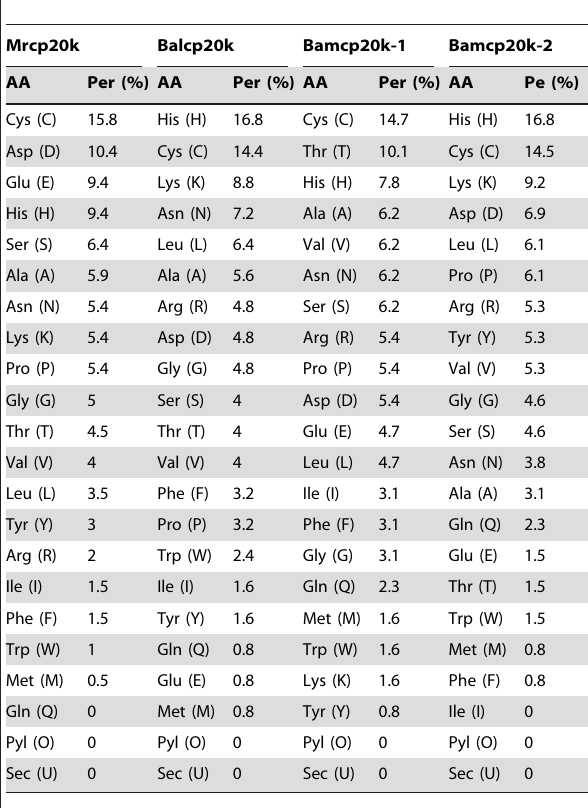
Table 1. Amino acid composition of the cp20k homologues from three